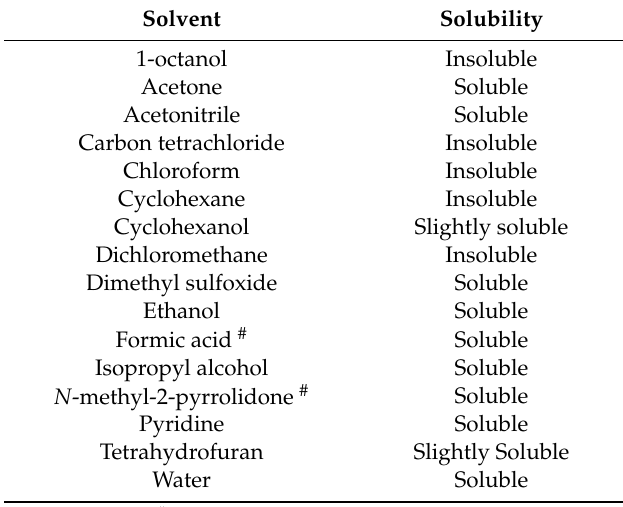
Table 1. Solubility test for PNIPAM- b -PANI in di ff erent solvents at 20 ◦ C. Solvent Solubility 1-octanol Insoluble Acetone Soluble Acetonitrile Soluble Carbon tetrachloride Insoluble Chloroform Insoluble Cyclohexane Insoluble Cyclohexanol Slightly soluble Dichloromethane Insoluble Dimethyl sulfoxide Soluble Ethanol Soluble Formic acid # Soluble Isopropyl alcohol Soluble N -methyl-2-pyrrolidone # Soluble Pyridine Soluble Tetrahydrofuran Slightly Soluble Water